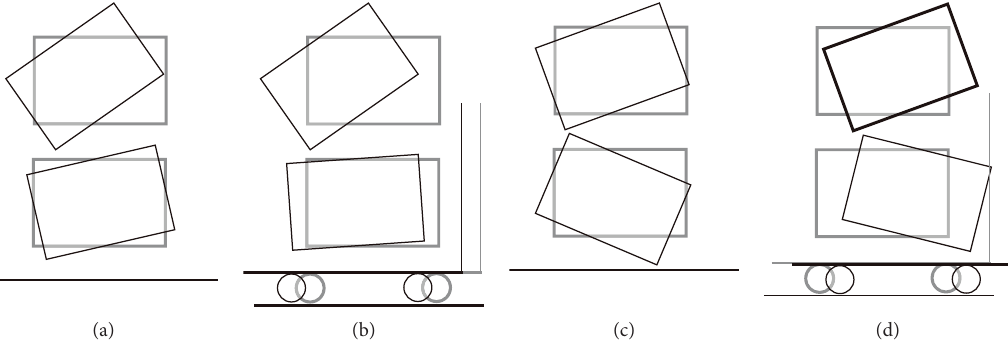
Figure 8: Mode shape of the roll and lateral model corresponding to the primary and secondary mode. (a) Roll model for primary mode; (b) lateral model for primary mode; (c) roll model for secondary mode; (d) lateral model for secondary mode.